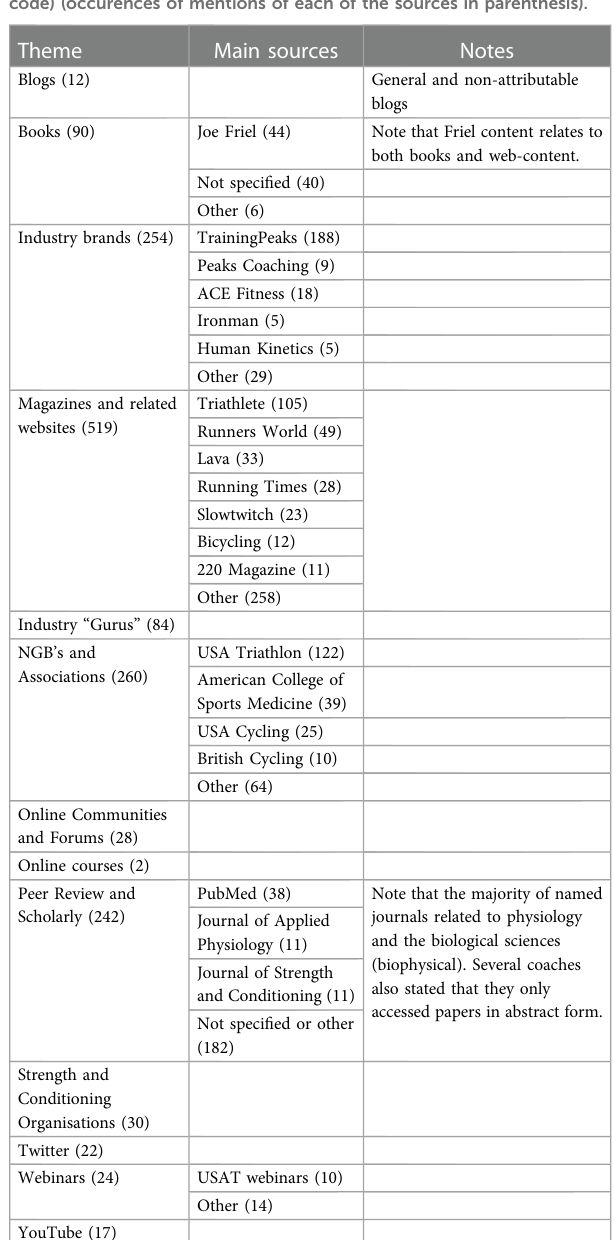
TABLE 9 Sources of information and knowledge for endurance coaches ( n =829 coaches; 1,640 sources identi fi ed; 36 responses not able to code) (occurences of mentions of each of the sources in